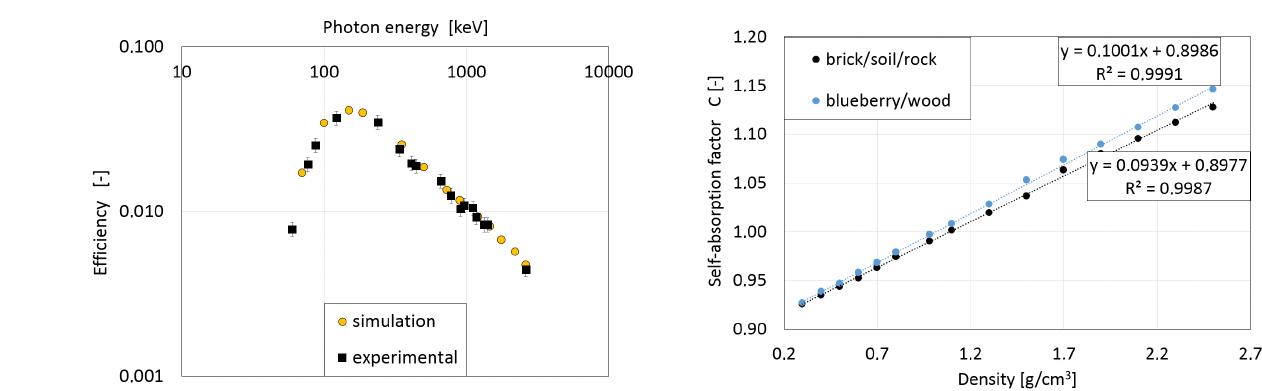
Figure 5. Correction factor for M600 as a function of density. Composition